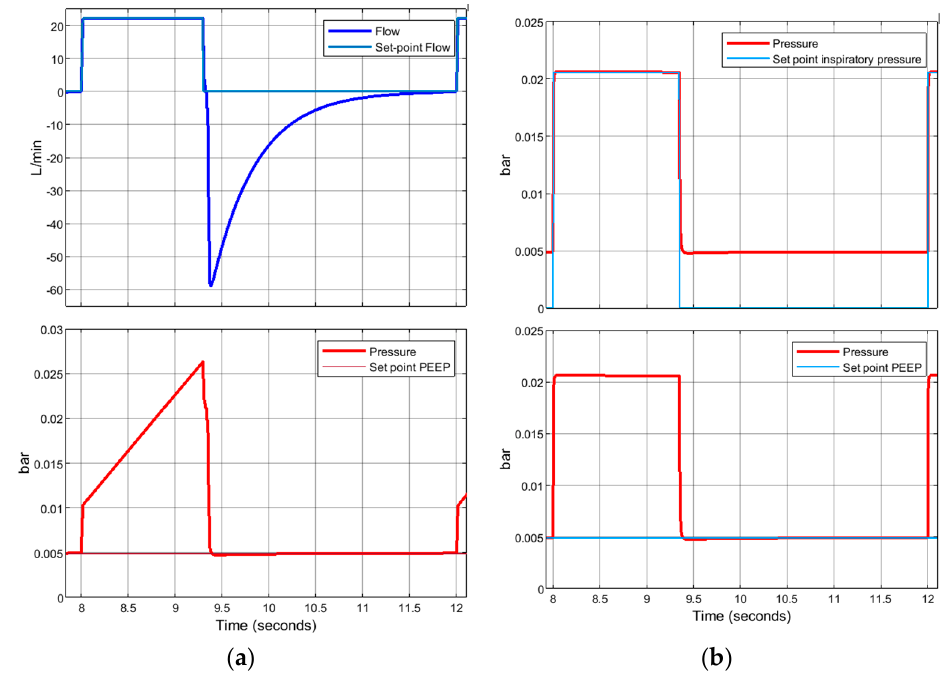
Figure 25. Case 2. Control system: ( a ) VC − CMV mode; ( b ) PC − CMV mode. Finally, the effects on inspiratory/expiratory resistance and lung compliance changes during the two previously analysed ventilation modes are evaluated in the Case 3. The considered data, shown in Figure 26, are taken from real ‐ life quantitative experiments re ‐ ported in the literature [49].